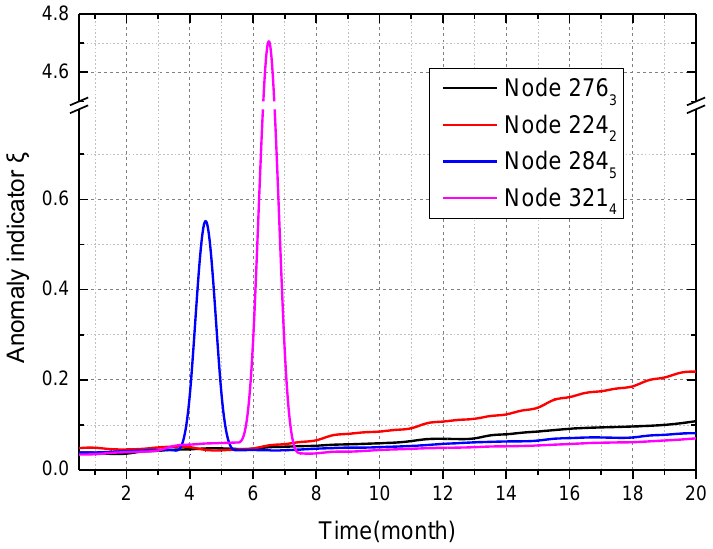
Figure 12. Anomaly indicator ξ of four sensor nodes over a long-term span.